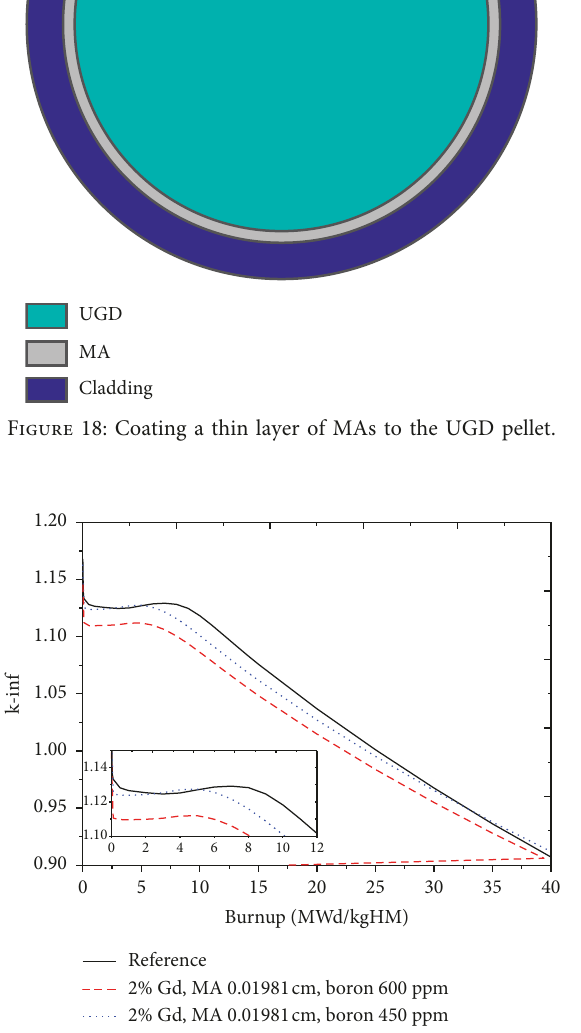
Figure 19: The k-inf versus burnup when coating a thin layer of MAs to the UGD pins and reducing GD to 2wt.%.